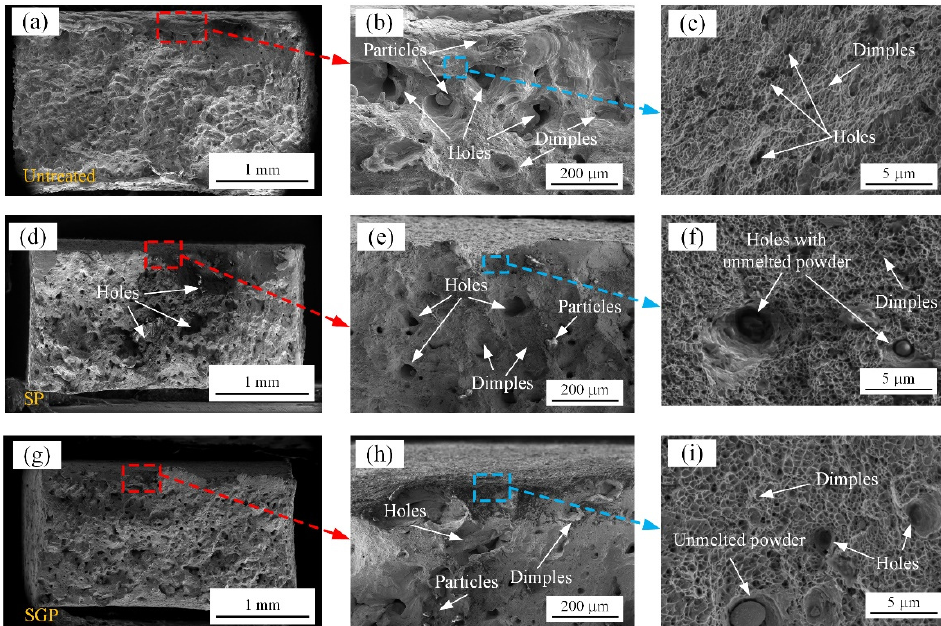
Figure 10. Fracture morphologies of the samples that undergo different processes, ( a , d , g ), which are the fracture microstructures of the untreated, SP, and SGP samples, respectively. ( b , c ) are the magnified views of the untreated sample; ( e , f ) are the magnified views of the SP sample; and ( h , i ) are the magnified views of the SGP sample.